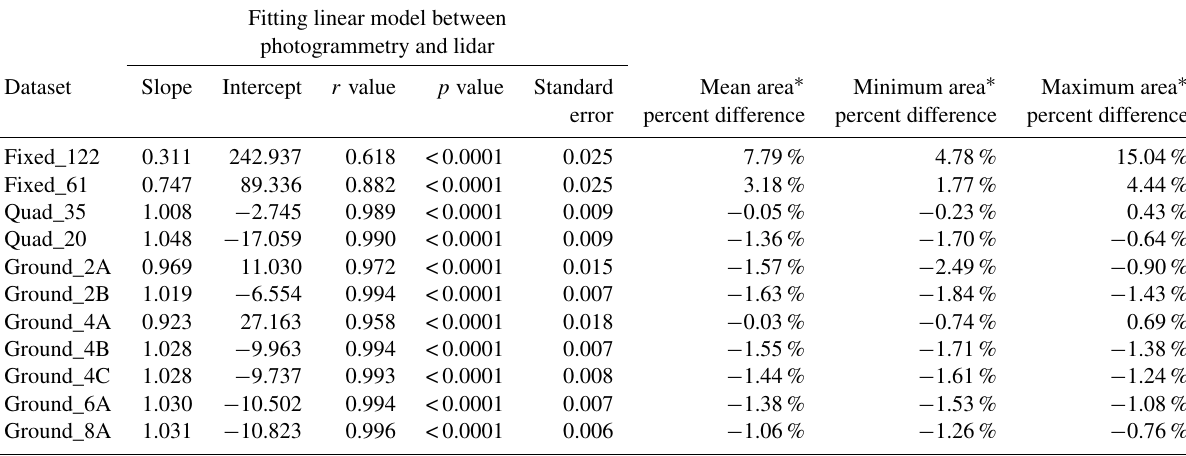
Table 7. Cross-sectional evaluation comparison between photogrammetry and lidar. Fitting linear model between photogrammetry and lidar